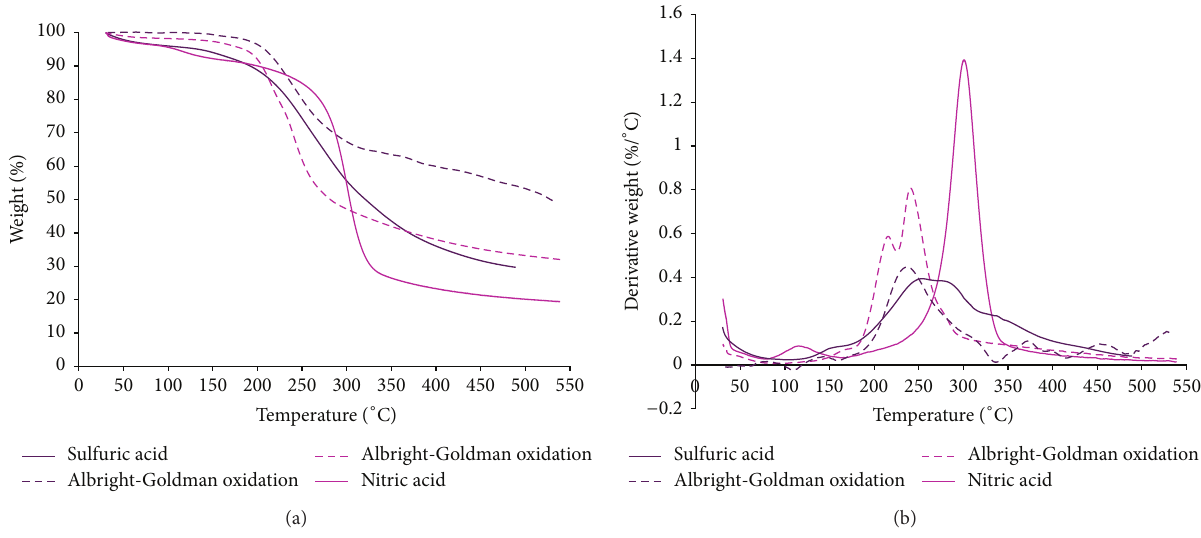
Figure 7: Thermogravimetric (TG) weight loss and derivative curves of modified (a) and hydrolyzed (b) cellulose extracted from wheat